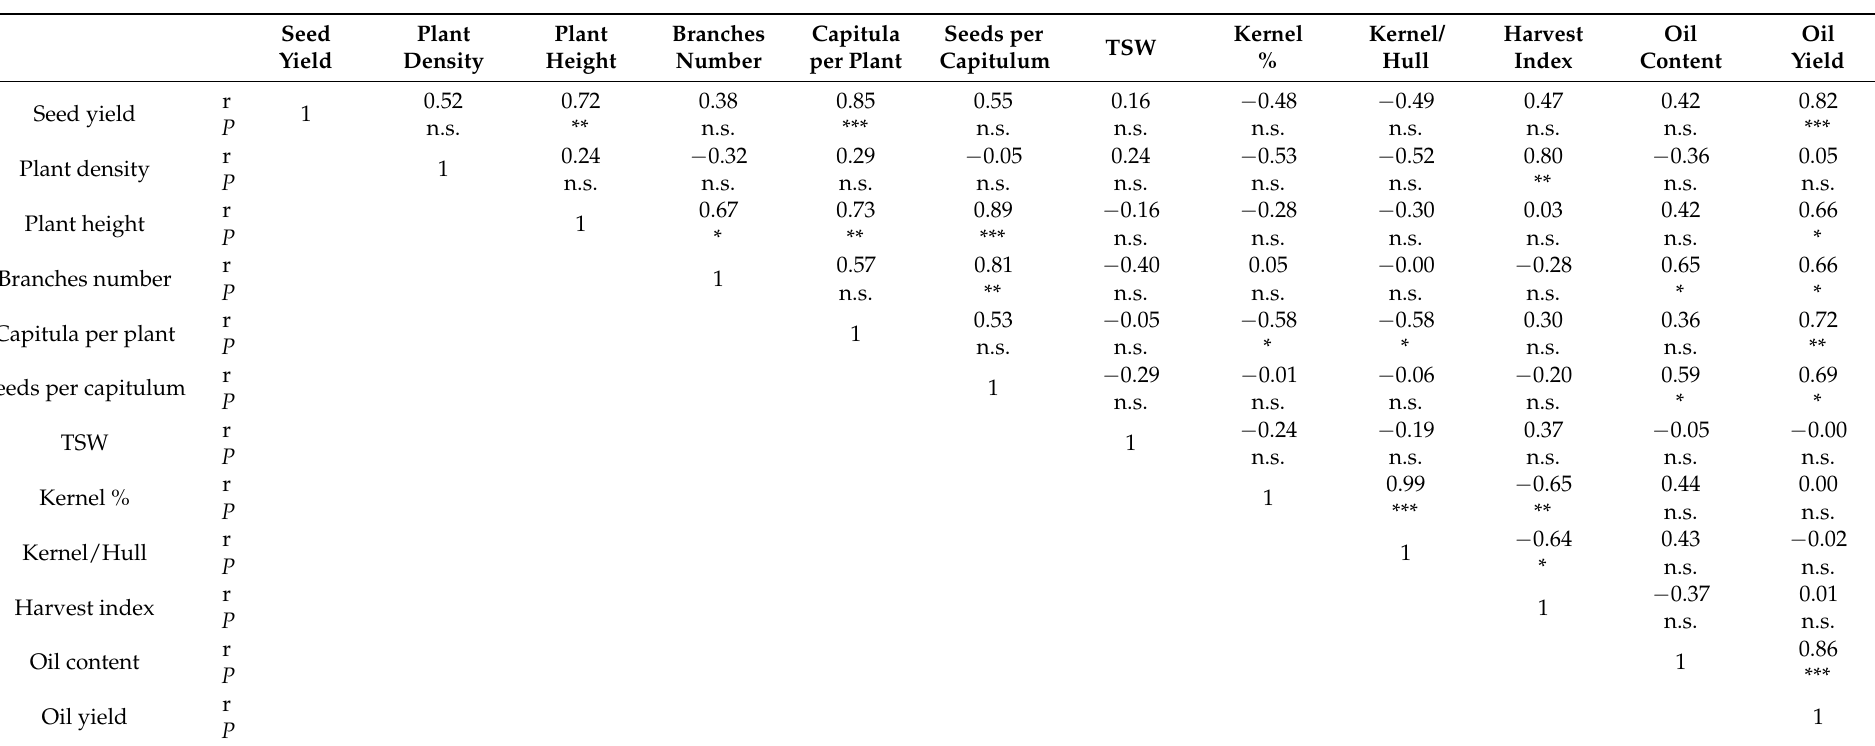
Table 8. Pearson’s correlation coefficients (r) and their statistical significance ( P ) among pairs of variables related to the expression of growth and yield in six safflower genotypes under two growing seasons (13 March 2012 and 18 April 2013). ***, significant at p ≤ 0.001 level; ** significant at p ≤ 0.01; *, significant